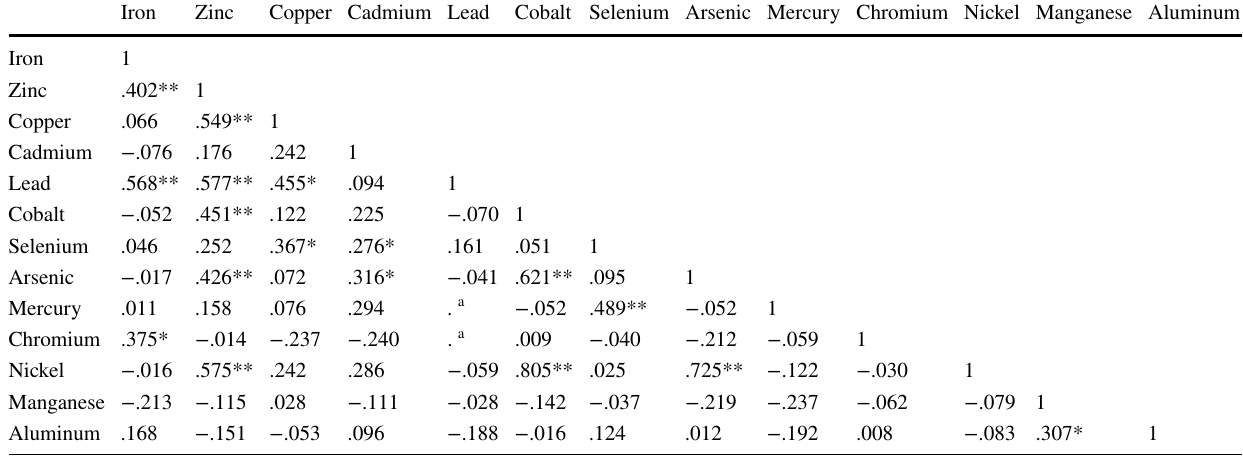
Table 3 Correlations between the variables of surface water in and around Talcher coalfield